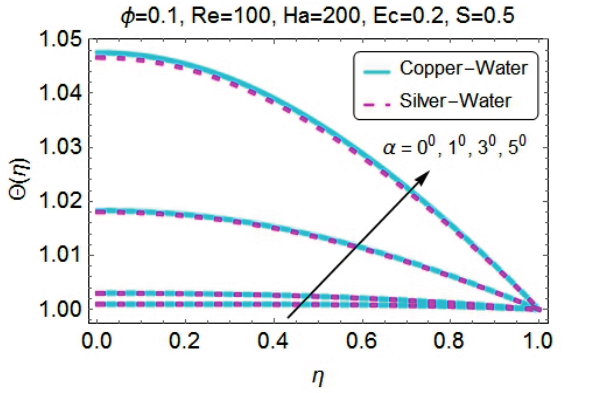
Figure 12. Change in temperature for varying α (divergent channel/stretching